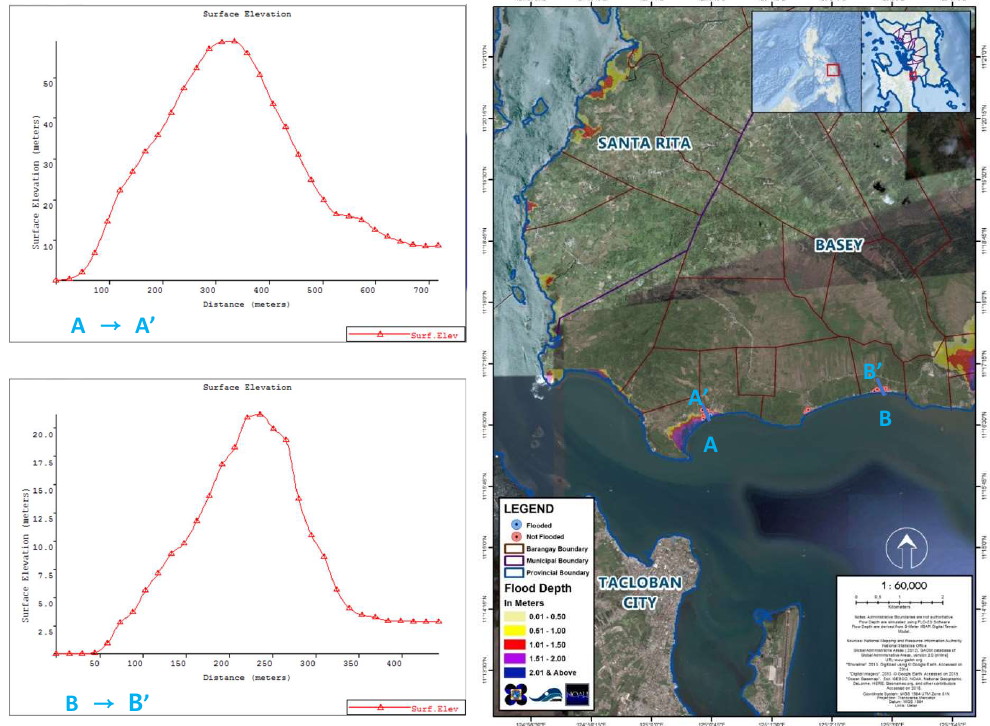
Figure 10 . Storm surge inundation (right panel) and cross-sectional x height elevation with no flooding (red line in left panel) for transects A to A′ and B to B′ (blue solid lines in right panel), showing effect of elevation in storm surge height.